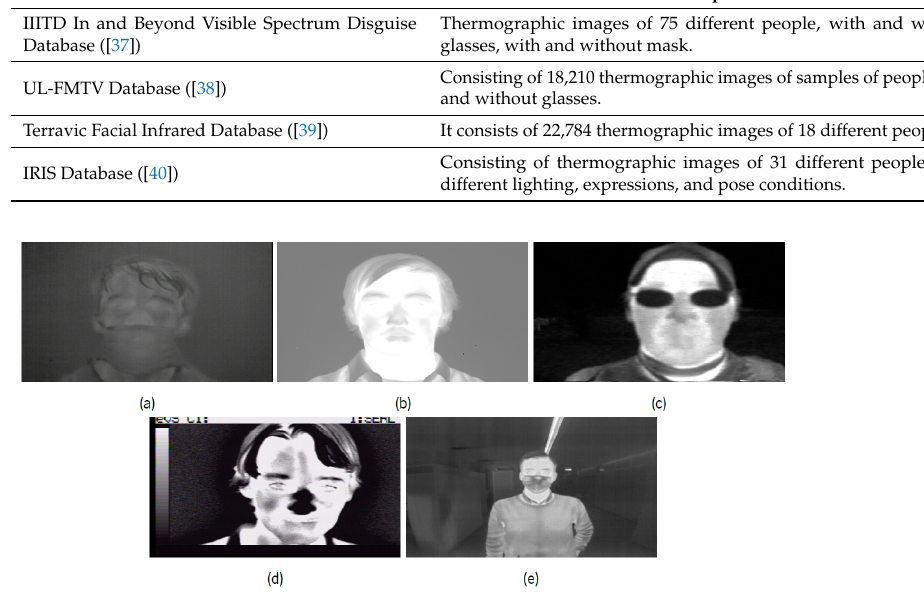
Figure 6. Sample examples of other thermographic datasets used for facial point detection task. ( a ) IIITD In and Beyond Visible Spectrum Disguise Database. ( b ) UL-FMTV Database. ( c ) Terravic Facial Infrared Database. ( d ) IRIS Database. ( e ) Sample collected in laboratory.